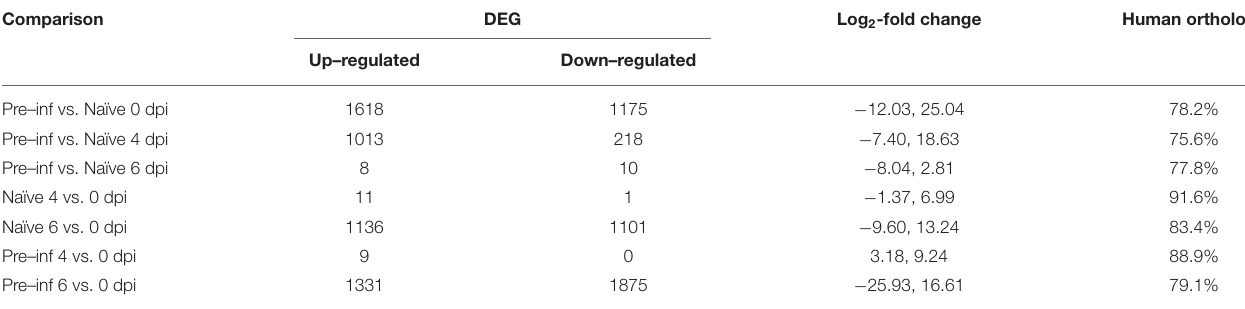
TABLE 1 | The number of differentially expressed genes (DEGs) for the different comparisons including log 2 -fold change and the proportion of genes with human orthologs. Comparison